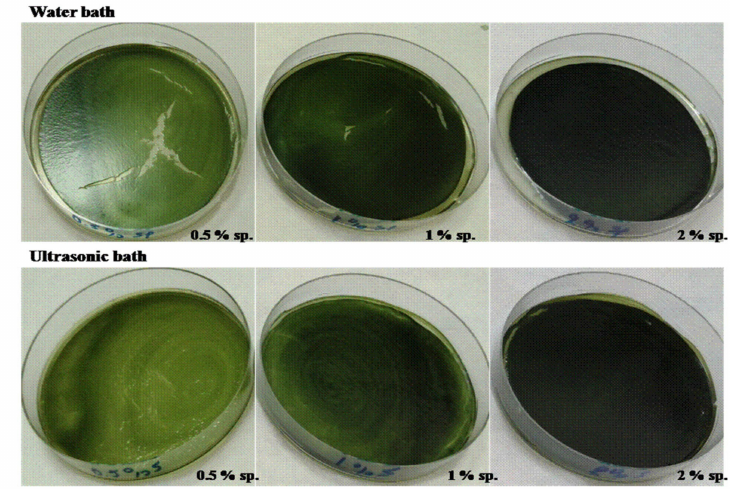
Figure 1. Macroscopic appearance of WPC-based films with spirulina in different concentrations with different